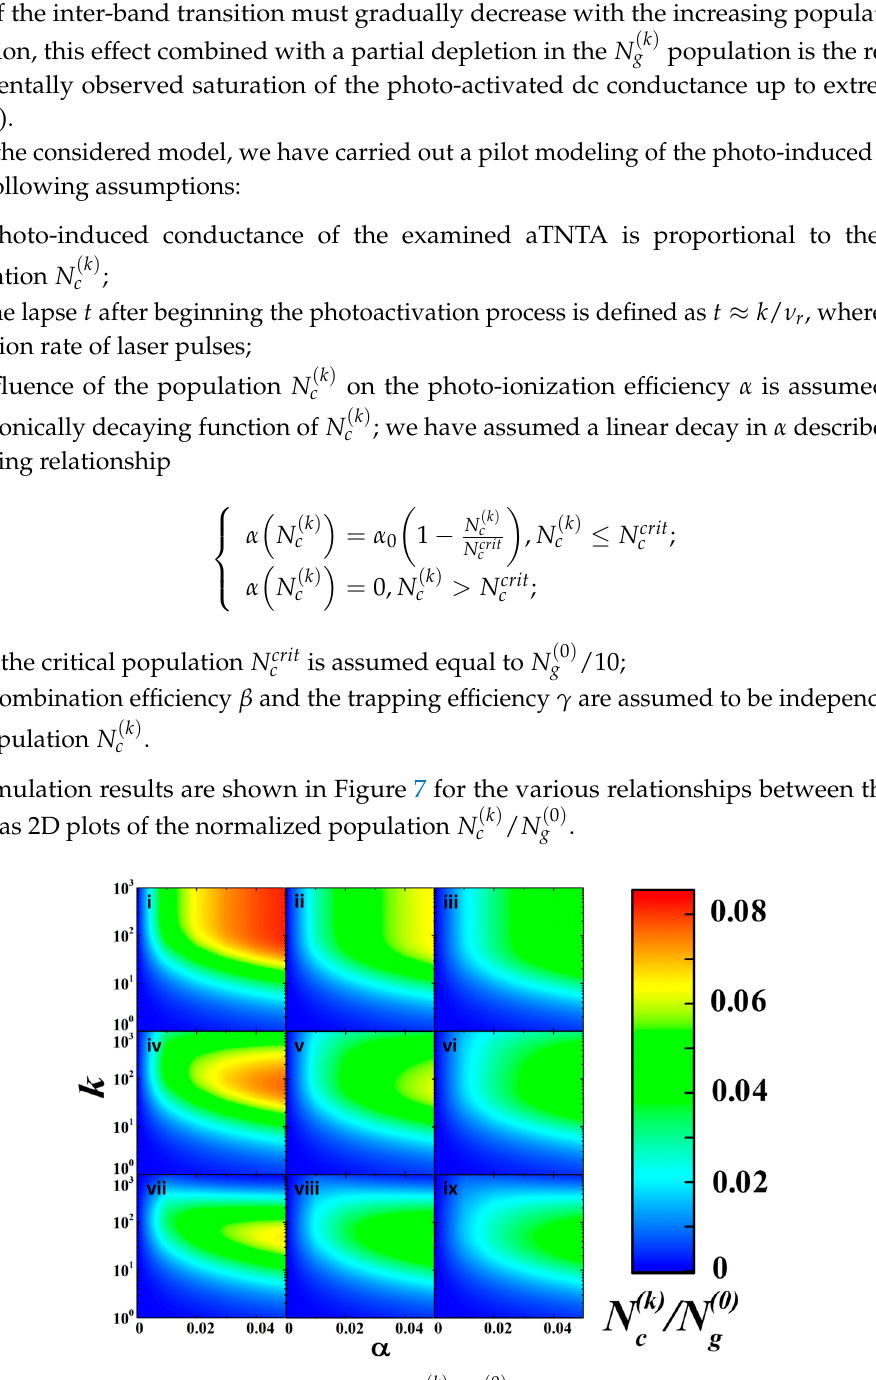
Figure 7. 2D plots of the normalized population N c / N g against the number of acting laser pulses and the initial efficiency of photo-ionization for the various values of β and γ . ( i ) β = 0.01, γ = 0; ( ii ) β = 0.025, γ = 0; ( iii ) β = 0.04, γ = 0; ( iv ) β = 0.01, γ = 10 − 3 ; ( v ) β = 0.025, γ = 10 − 3 ; ( vi ) β = 0.04, γ = 10 − 3 ; ( vii ) β = 0.01, γ = 5 × 10 − 3 ; ( viii ) β = 0.025, γ = 5 × 10 − 3 ; ( ix ) β = 0.04, γ = 5 × 10 − 3 .